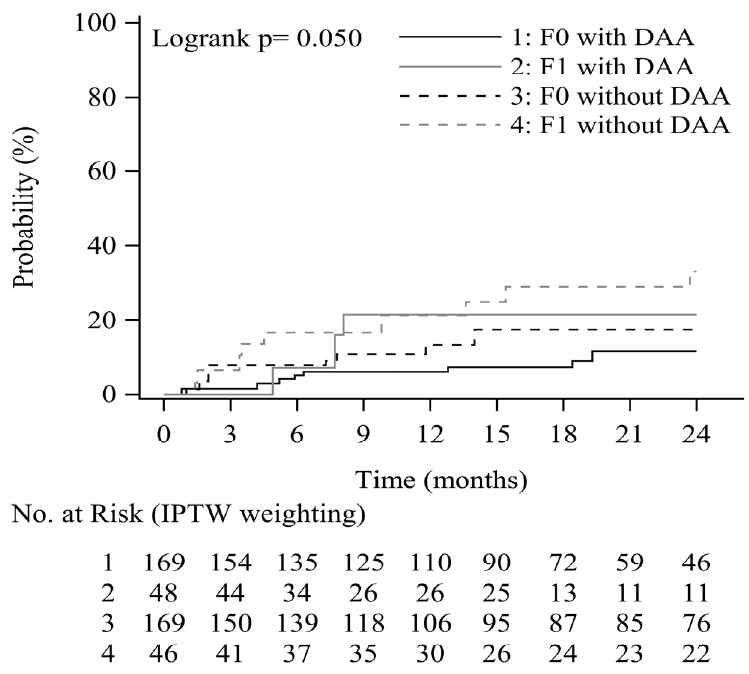
Figure 3. EV progression rate by EV form and DAA